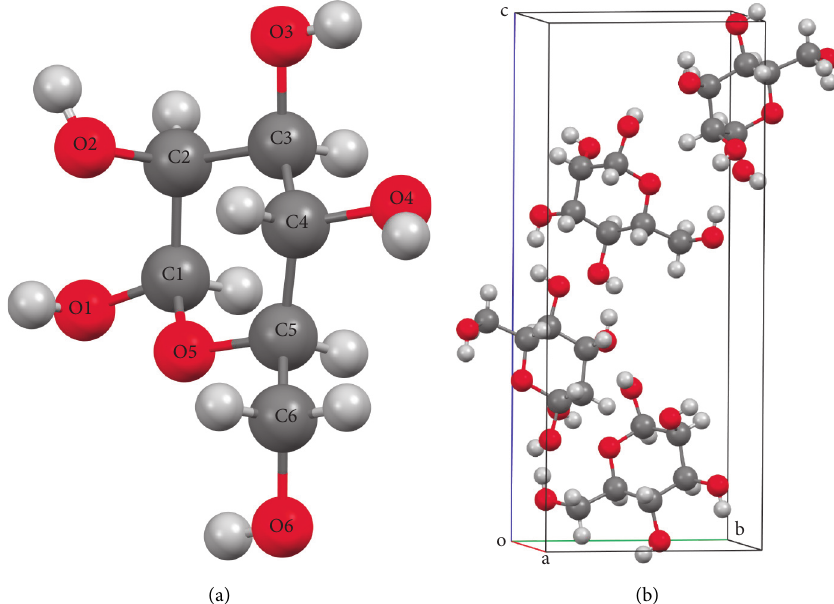
Figure 1: (a) Atom labeling scheme for mannose in the form of zwitterion and (b) molecular packing in the unit cell. Atom colors: oxygen, red; carbon, grey; and hydrogen, white. Only the mannose molecule is depicted in the figure, for the reason that the labeling schemes for mannose and galactose are the same as these molecules are structurally equivalent, differing only in the spatial position of the four chiral carbons.